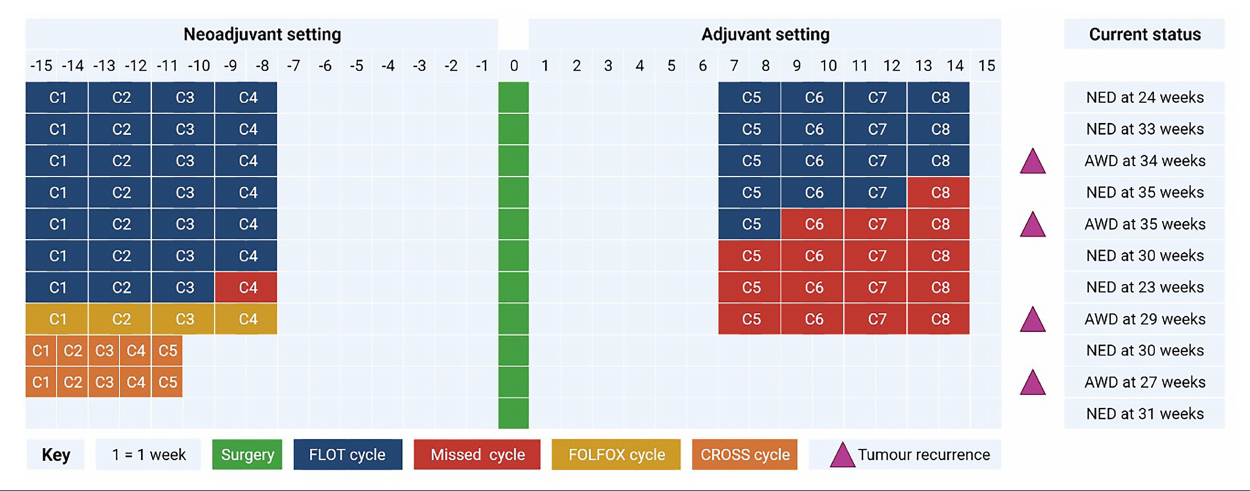
TABLE 1 | Treatment modalities, cycles tolerated, tumor recurrence.